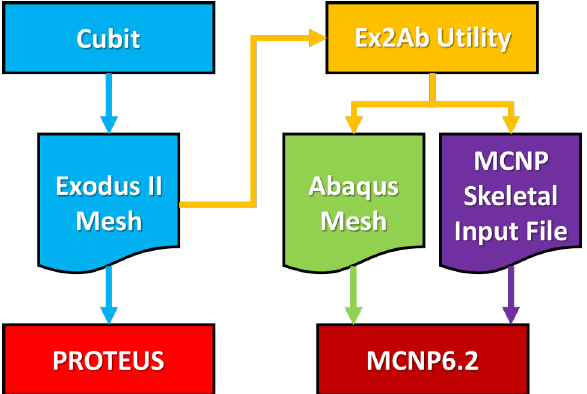
Figure 6: PROTEUS-MCNP model